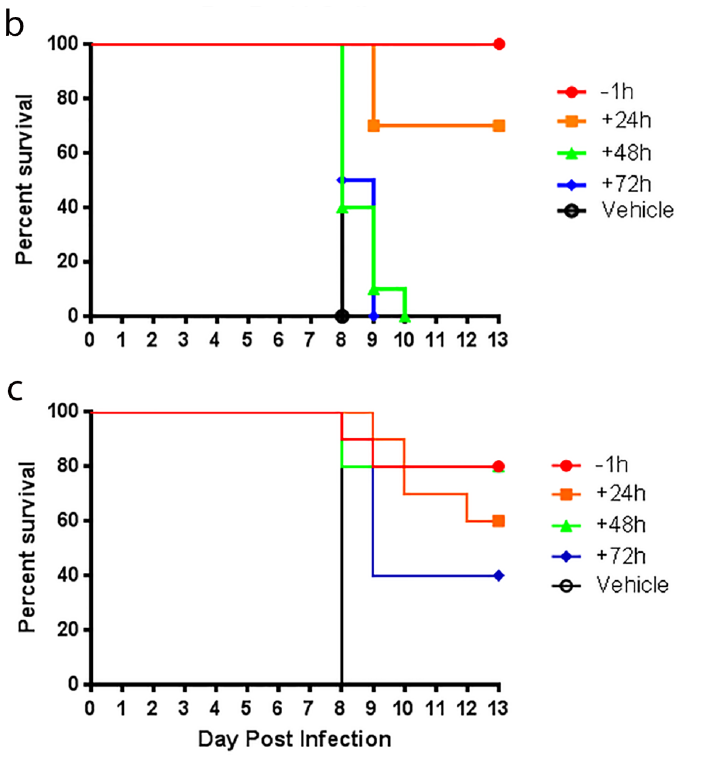
Figure 3. Protection by UV-12 in an INFV H1N1 mouse model. ( a ) BALB/c mice ( n = 10/group) were treated orally with 100, 80, 60, 40 or 20 mg/kg of UV-12 or